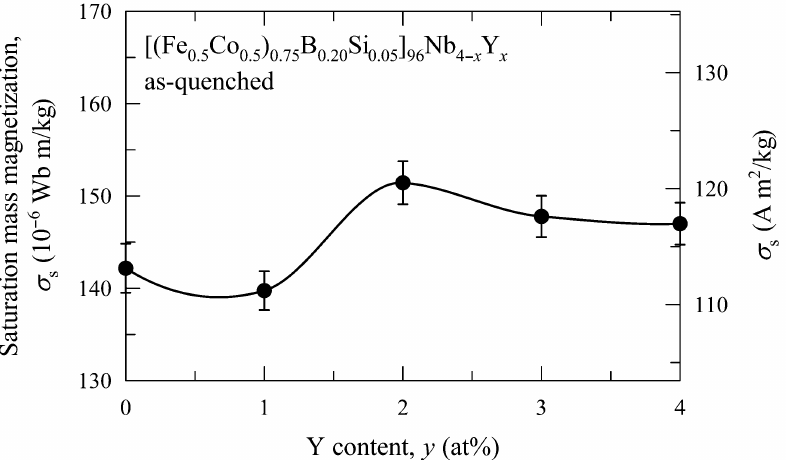
Figure 6. Saturation mass magnetization (σ s ) of [(Fe 0.5 Co 0.5 ) 0.75 B 0.20 Si 0.05 ] 96 Nb 4− x Y x alloys in an as-quenched state as a function of Y content. The graph shows the mean value for the five specimens (closed circles). The error bars represent the 95% confidence limits (±2 × standard